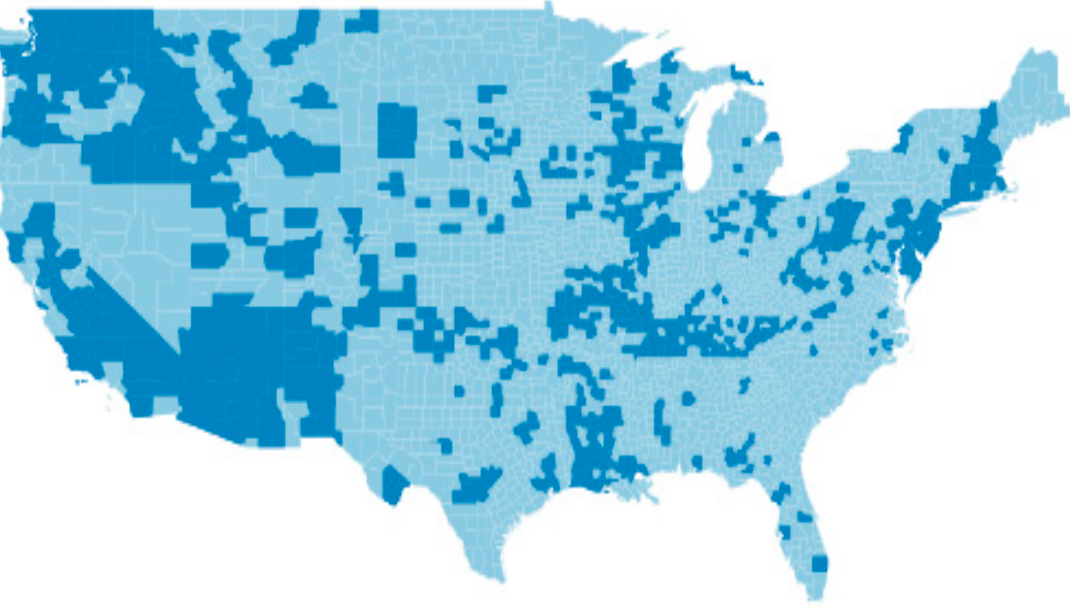
Figure 1. US (48 states) showing counties (in dark) that are included in the analytic dataset.